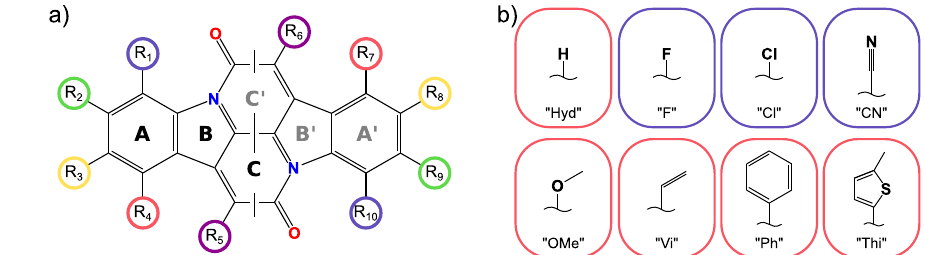
Fig. 2 Structure of studied molecules. a Core scaffold of cibalackrot with residues R 1 --R 10 colour coded with respect to inversion symmetry. The dashed line separates two parts that are referred to as the half-structures. The 5- and 6-membered rings are labelled A, B, C and their inversion symmetric counterparts are labelled A', B', C', respectively. b Chemical substituent groups used to construct the chemical space. The coloured frame around each substituent marks its role as electron withdrawing (blue) or electron donating group